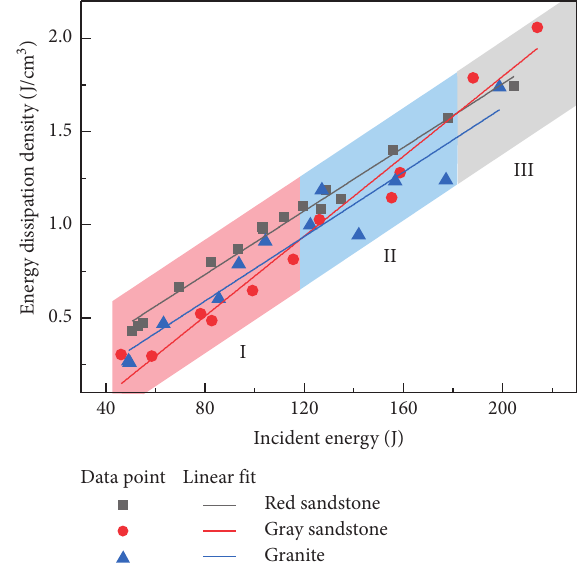
Figure 13: Energy dissipation density-incident energy diagram.